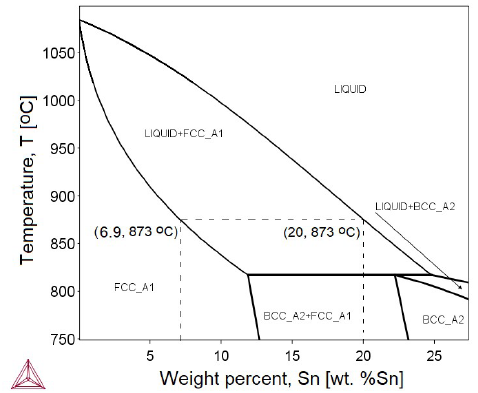
Figure 2. Binary phase diagram for the Cu - 20 wt.% Sn system calculated by Thermo-Calc Software 36 with TCBIN database.